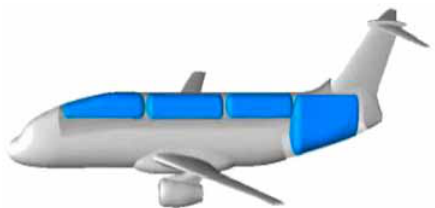
Fig. 1. Traditional cryogenic plane layout in Khandelwal et